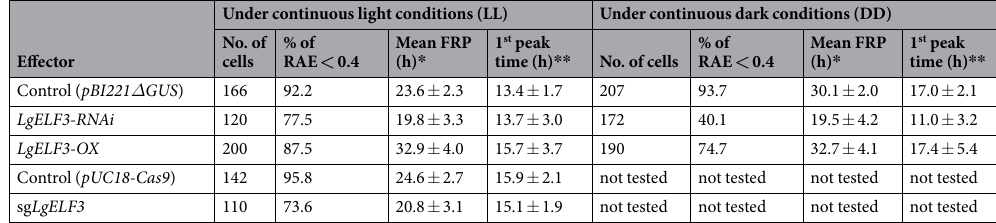
Table 1. Summary of the circadian properties of individual cells in co-transfection assays with the AtCCA1::LUC reporter. * Means ± S.D. were calculated using data of cells with relative amplitude error (RAE) values < 0.4. ** Means ± S.D. were calculated using data of peak times in the range between 0 h and 24 h. Time 0 h was the onsets of measurement shown in Supplementary Figs 1 and